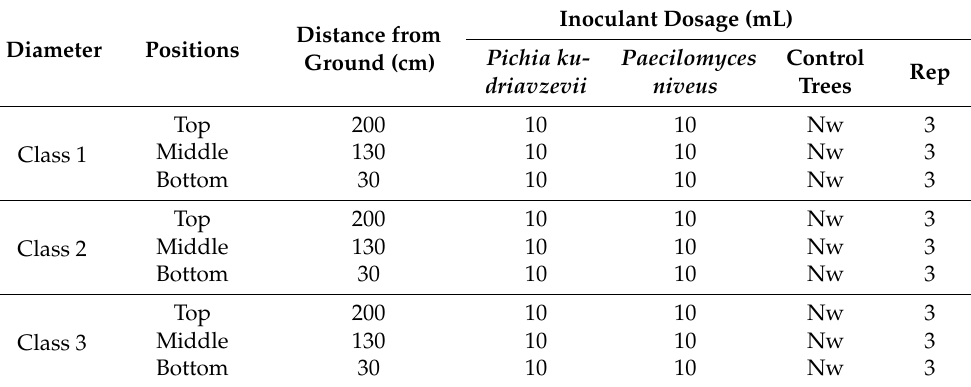
Table 2. Inoculation Treatments with Selective Diameter Classes, Inoculation Positions, Inoculation Types, and Replication in Standing A. malaccensis Trees.